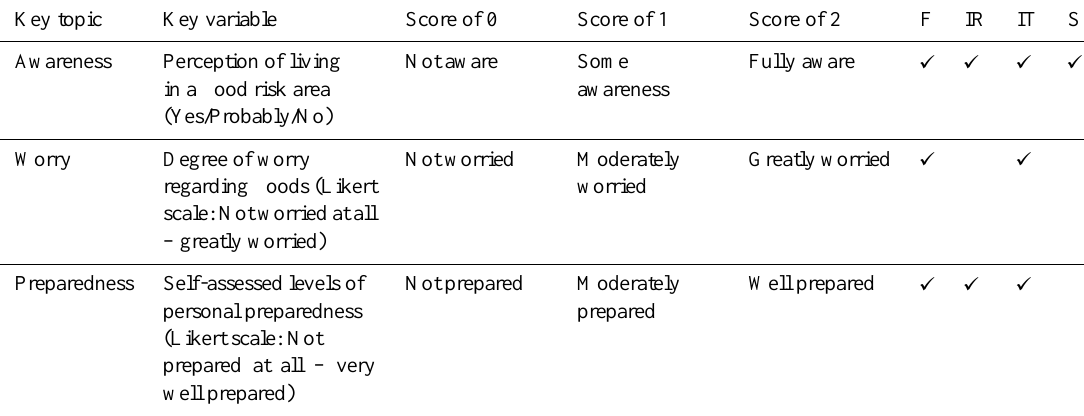
Table 2. Key variables investigated in questionnaires in Finland (F), Ireland (IR), Italy (IT) and Scotland (S) as well as scoring system for resilience profiling (Score of 0–2).